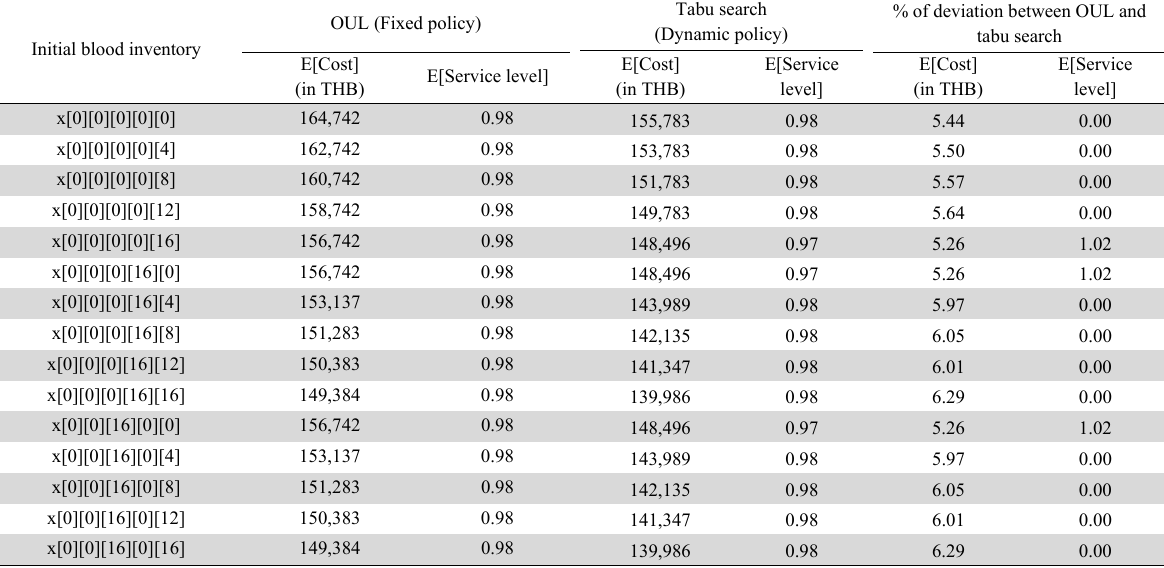
Comparison of the solutions of tabu search and the solutions of the OUL with varying number of iterations Initial blood